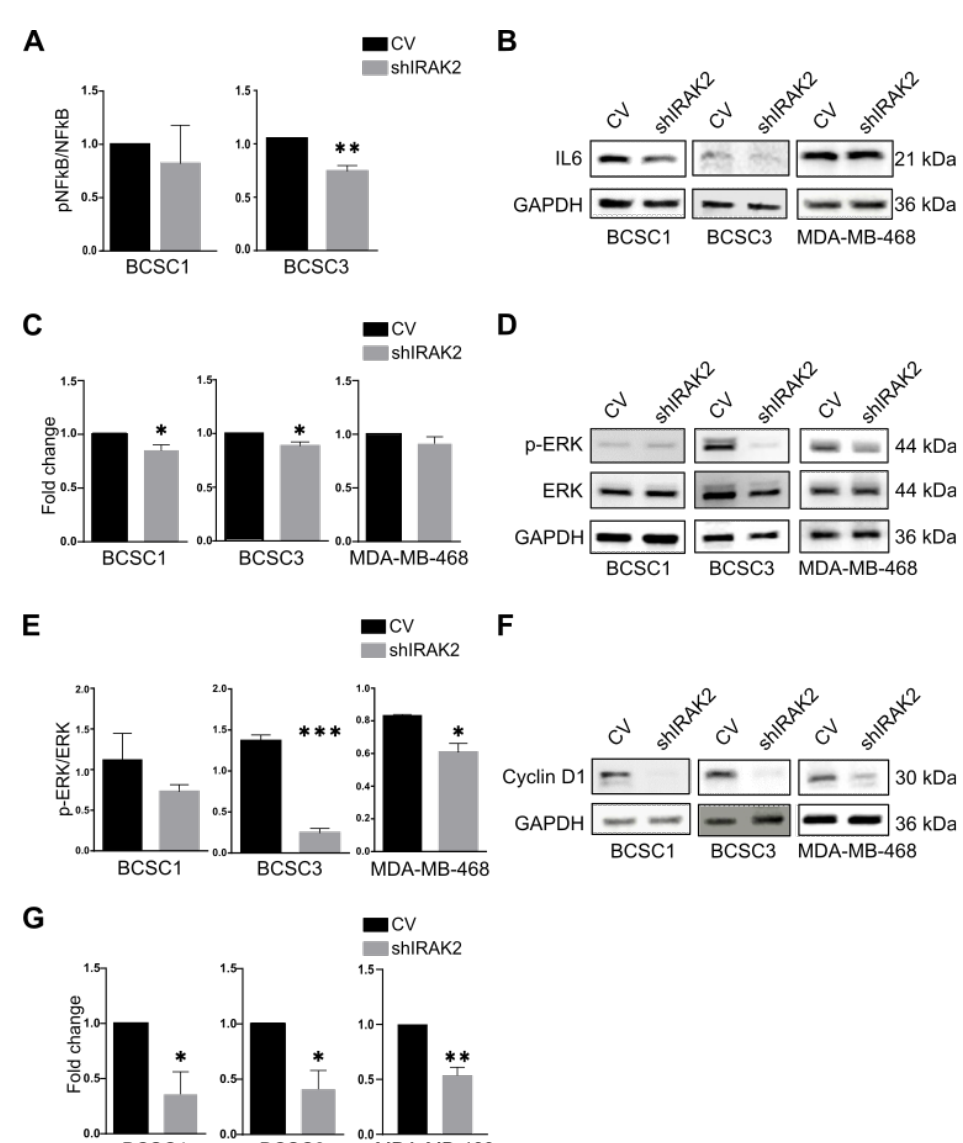
Figure 2. NF- κB and ERK phosphorylation and IL -6 and cyclin D1 expression are reduced by IRAK2 knockdown. ( A ) NF- κB phosphorylation in BCSC1 and BCSC3, comparing control (CV) and IRAK2 knockdown cells (shIRAK2). The NF- κB activity was assessed after culturing the cells for 5 days in the presence of doxycycline and using the EnzyFluo phosphorylation assay kit (BioAssay Systems, ABIN5691837). The NF- κB activity was defined by normalising the signal of phosphorylated NF - κB (pNF- κB) to the signal of the NF - κB total protein content. Data (n = 3) are presented as means ± SEM; statistical analysis was performed using unpaired Student’s t -test. ( B – G ) IL-6 expression ( B ) and its quantification ( C ), ERK phosphorylation (pERK) and total protein content ( D ) and its quantification ( E ), cyclin D1 expression ( F ) and its quantification ( G ) assessed using Western blot in BCSC1, BCSC3 and MDA-MB-468 CV and shIRAK2 cells cultured in doxycycline-containing medium for 5 days. Data are presented as means ± SEM; statistical analysis was performed using unpaired Student’s t -test. *, p < 0.05; **, p < 0.01; ***, p <